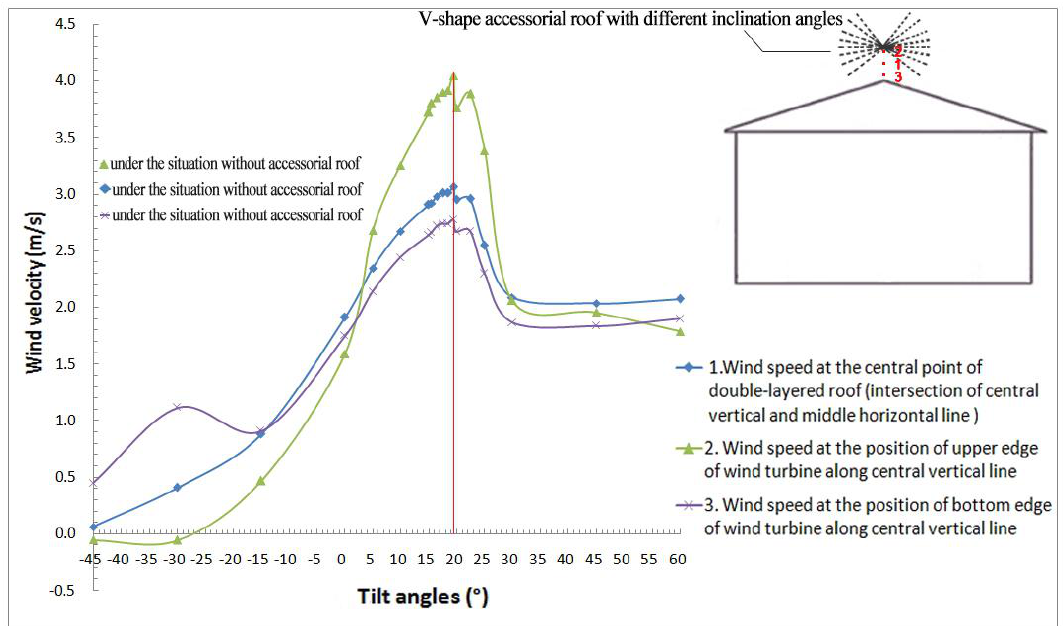
Figure 10. Wind speed distribution along the central vertical line between the two-layers of the roof structure at different tilt angles of the VRGV [46].